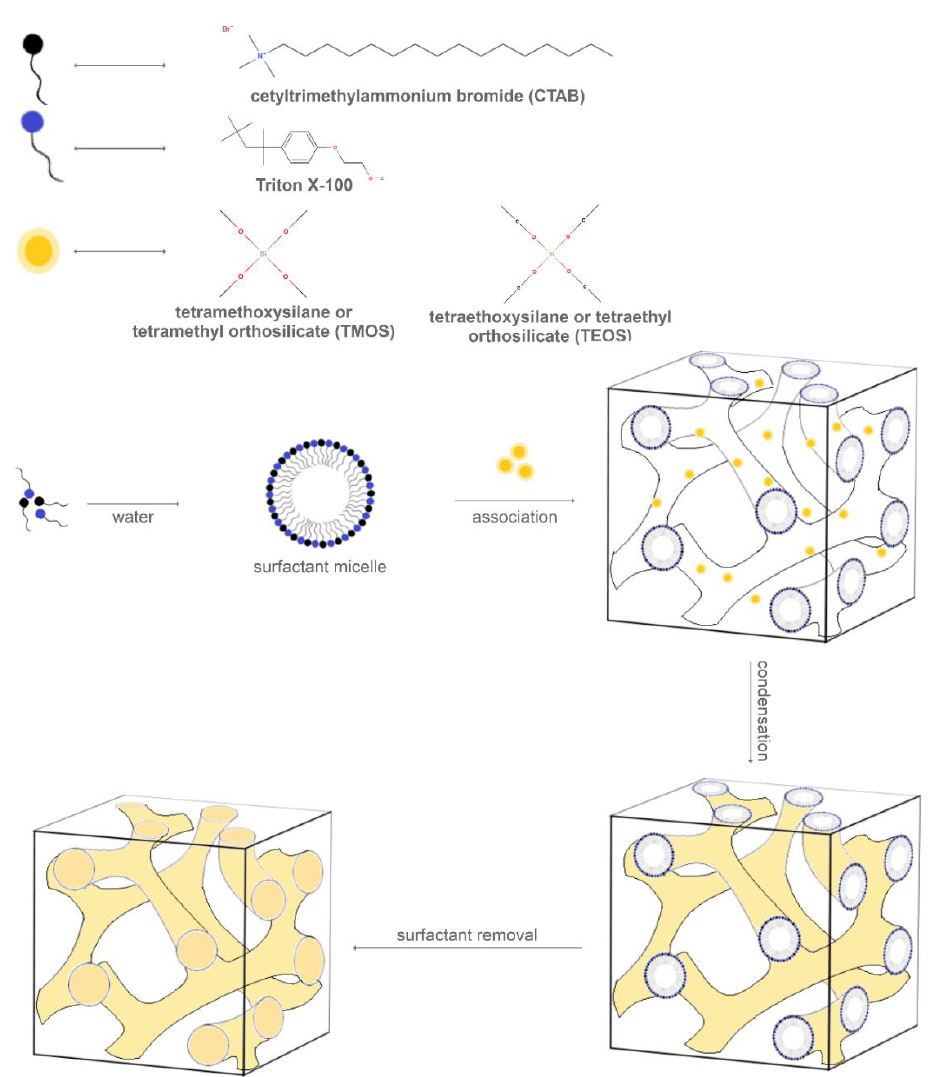
Figure 3. A schematic diagram of the processes involved in the synthesis of MCM-48.